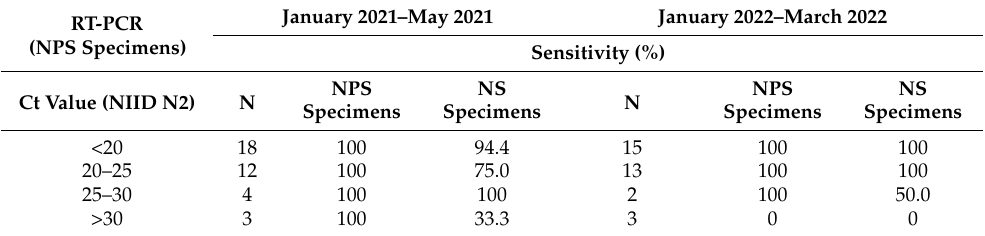
Table 6. Sensitivity of the FUJIFILM COVID-19 Ag test according to the study